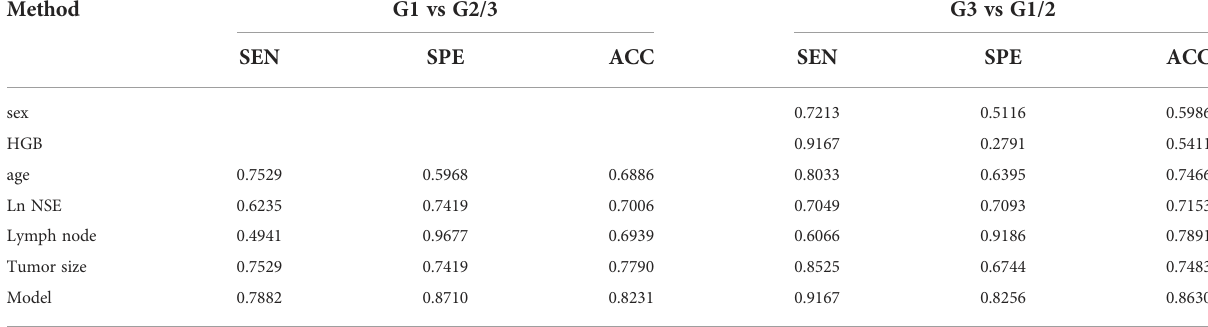
TABLE 4 Diagnostic performance of the model for grade status of GI-NET.